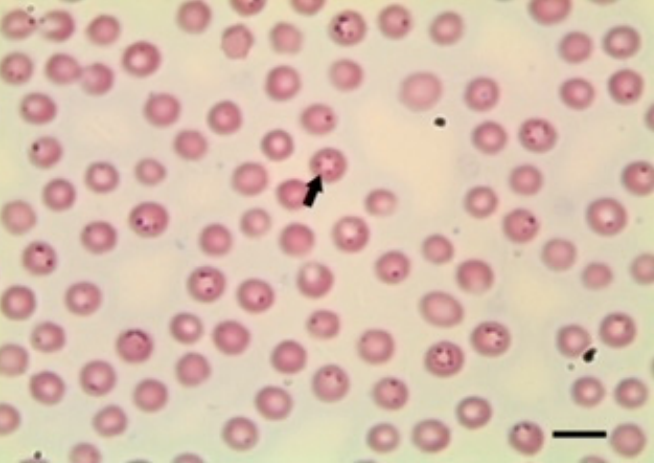
Figure 2. B. ovis sporozoites in erythrocytes. Scale bar indicates 5 μ m. Image courtesy of Professor Khaled El-Dakhly, Beni-Suef University, Egypt.